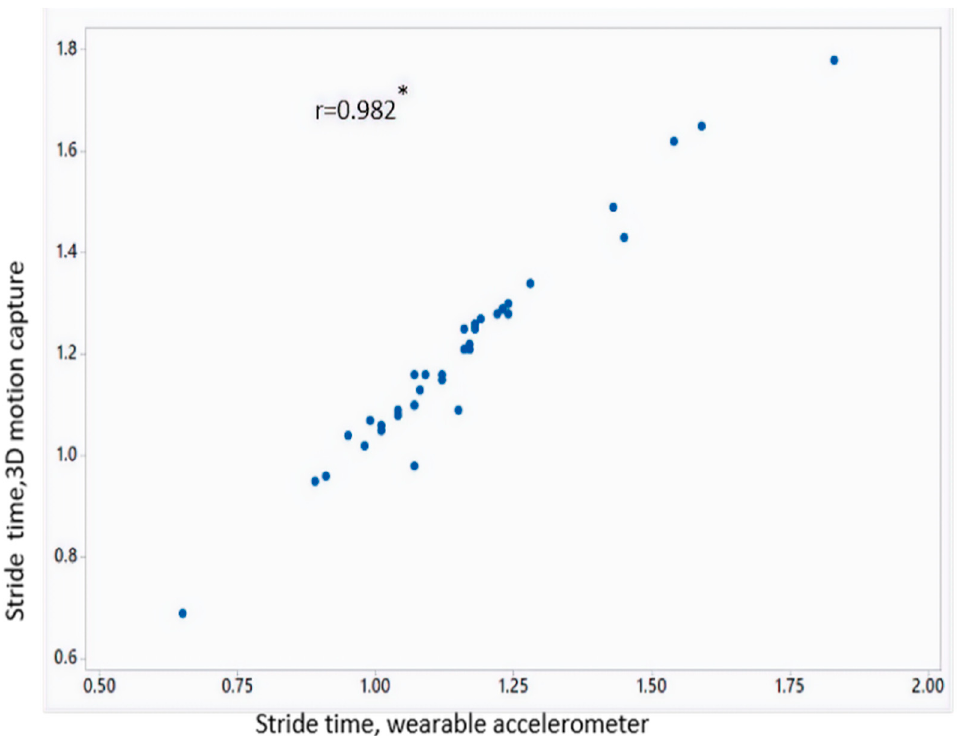
Figure 6. Correlation plot of stride time estimated from wearable accelerometer-based approach and 3D motion capture system (* p < 0.01).